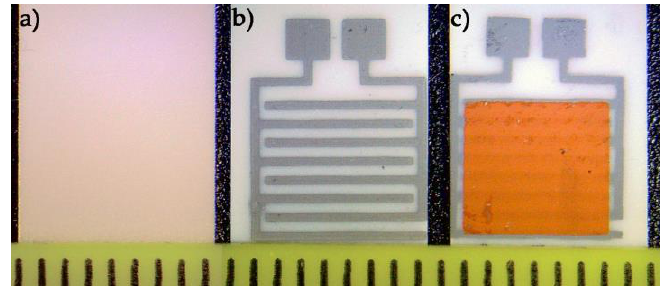
Figure 1. Preparation steps of sensing film, ( a ) Al 2 O 3 substrate, ( b ) Al 2 O 3 substrate with IDEs, ( c ) sensing film over screen-printed IDEs (scale bar in mm; sensing material printed area: ca. 31 mm 2 ).